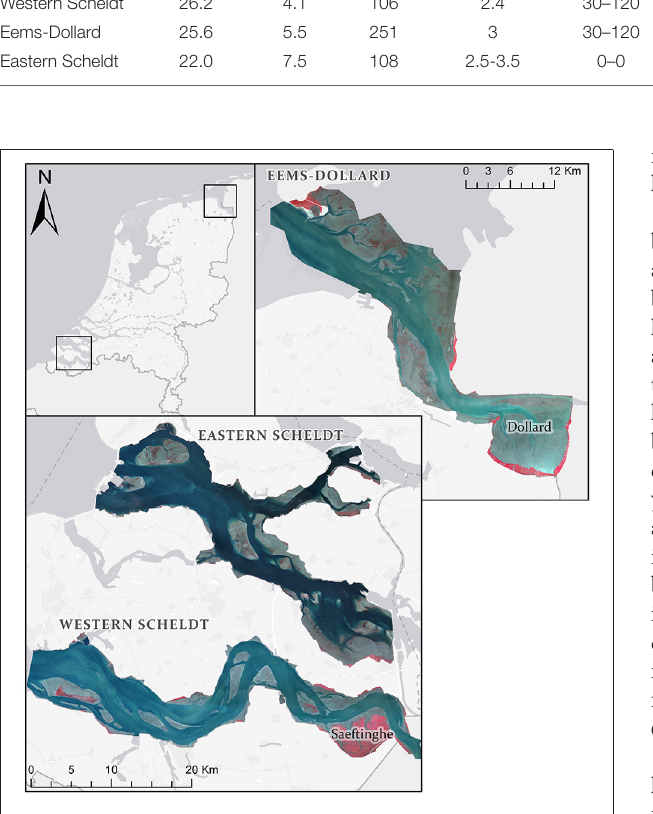
FIGURE 1 | Map of study areas with stretched false color aerial photographs. Within the estuaries, gray tones are bars, blue tones are water with lighter tones having more suspended sediment and red tones are vegetation or sometimes diatoms. Shading outside the estuaries: light gray is built area, white lines indicate roads and other infrastructure (including the storm surge barrier), dark gray is water of the sea and of embanked lakes. The landward boundary of the Western Scheldt is the Belgian-Dutch border and the eastern boundary of the Eems-Dollard is the German-Dutch border. The photographs were taken in 2016 in the Western Scheldt, 2016 in the Eastern Scheldt and 2014 in the